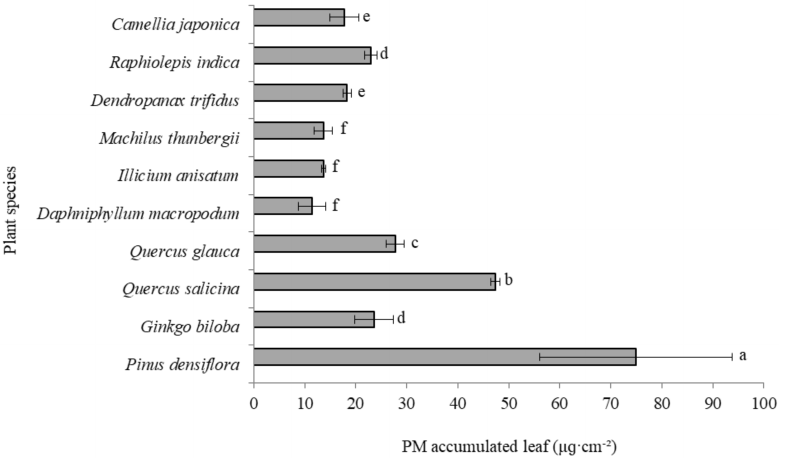
Figure 3. Total amount of particulate matter (PM) accumulated on leaves of eight evergreen and two coniferous species. Data presented as mean ± standard deviation (SD), with 5 replicates of 30 leaves each. Bars marked with different letters are significantly different by Duncan multiple test ( p <